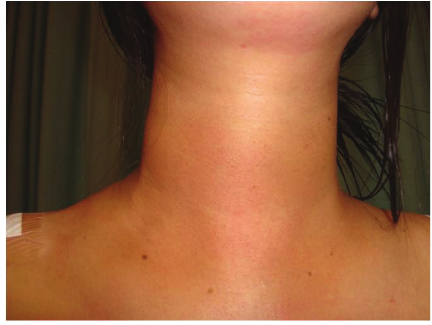
Figure 3: Local condition